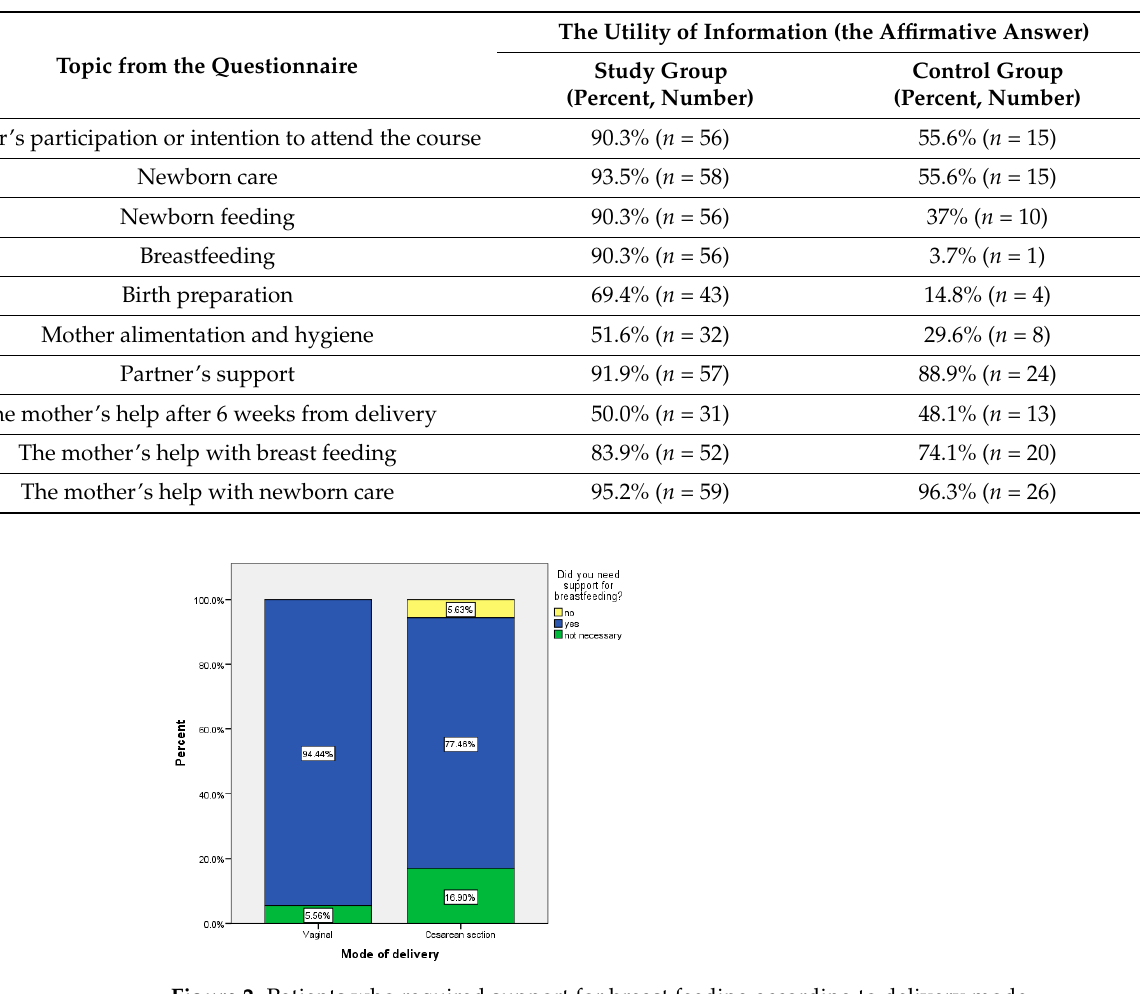
Figure 2. Patients who required support for breast feeding according to delivery mode.